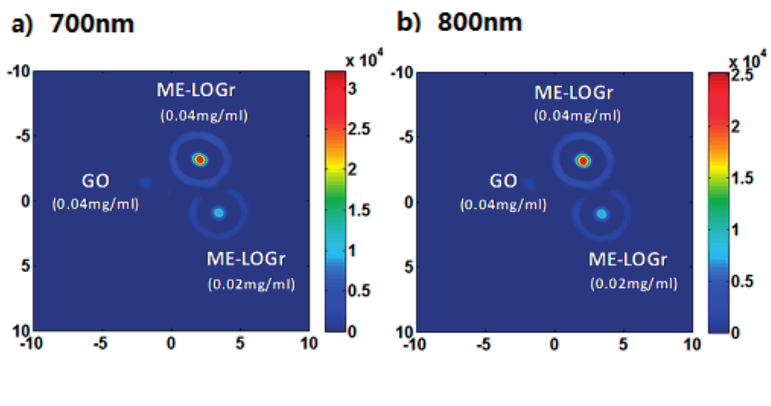
Figure 4. Photoacoustic (PA) signal of GO and ME-LOGr nanosheets of different concentrations, illuminated with 700 ( a ) and 800 ( b ) nm laser. The color coded vertical bar represents the strength of the photoacoustic signal generated. GO nanosheets were obtained via control-A experiment where nitronium ions and KMnO 4 both act as an oxidant. (Reprinted from reference [44]. Copyright with permission from © 2013 American Chemical